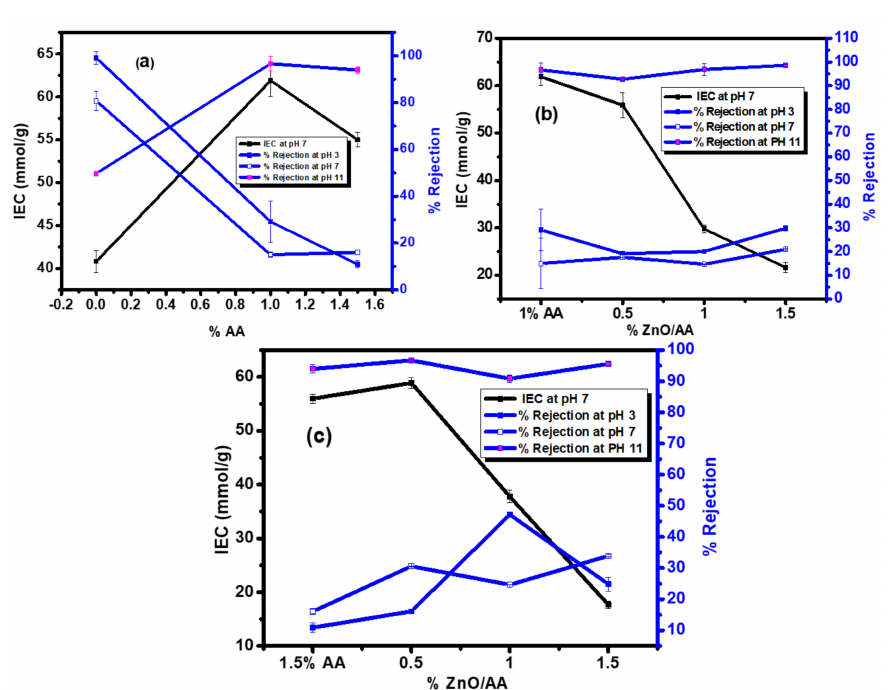
Figure 11. The variation of IEC performed at pH 7 for the PA–TFC membranes modified with 0.00% AA (unmodified membrane) and membranes modified with: ( a ) 1.00% AA, 1.5% AA; ( b ) 1.00% AA, 0.50:1.00% ZnO/AA, 1.00:1.00% ZnO/AA, and 1.50:1.00% ZnO/AA; and ( c ) 1.50% AA,